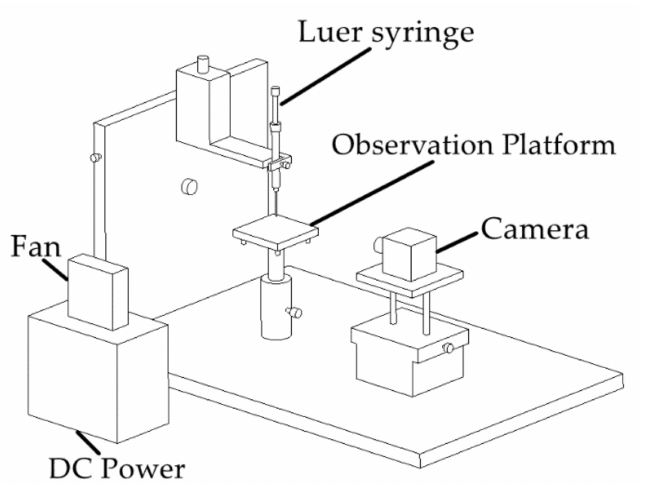
Figure 1. Experimental